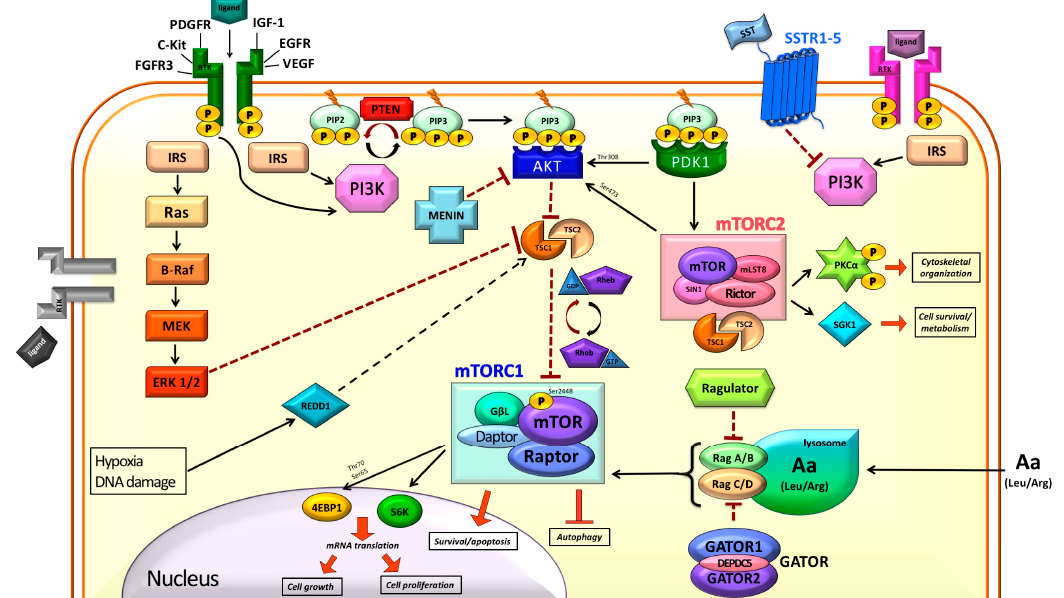
Figure 1. Schematic representation of the phosphoinositide-3-kinase (PI3K)/protein kinase B (AkT)/ mechanistic target of rapamycin (mTOR) pathway. Black arrow: direct activation; Dotted black arrow: activation through unknown/not diasplayed other molecules; Dotted T bar: inhibition; Black/red twisting arrows: activation/inactivation conversion; Red arrow: promotion of processes; Red T bar: inhibition of processes; P in yellow spheres: phosphate group.